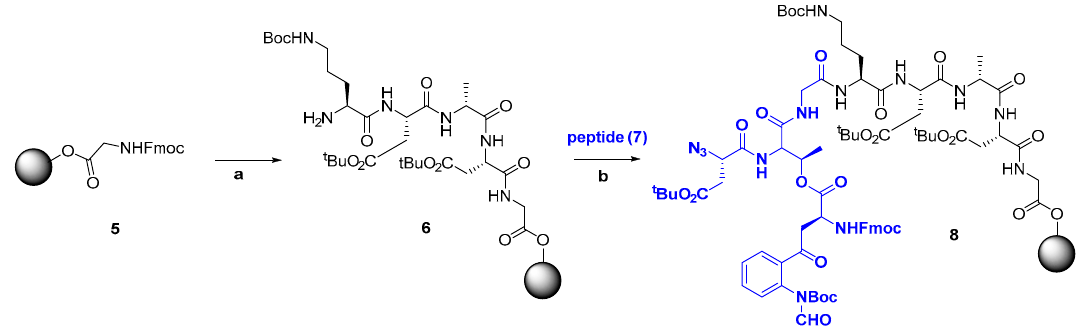
Scheme 5. Ligation of peptides in the synthesis of a precursor of polymixin E. Reaction conditions : ( a )